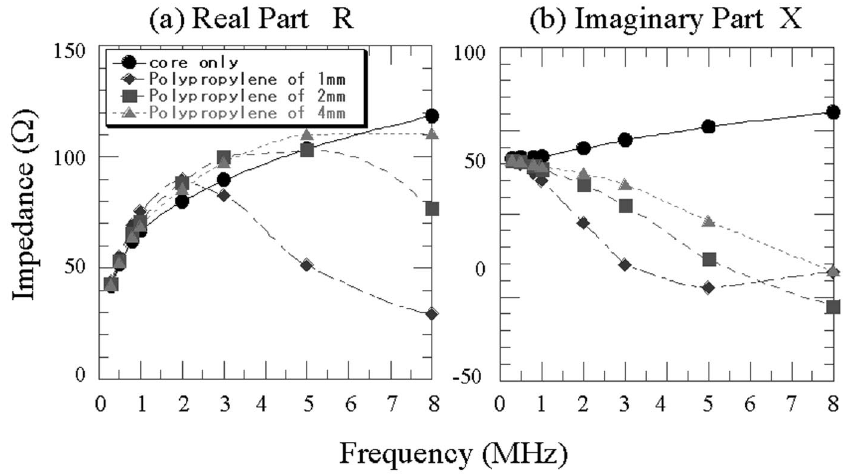
FIG. 5. Core impedances for the case after installing polypropylene sheets of 0.5 mm (triangles), 1 mm (squares), and 2 mm (diamonds) thickness. Polypropylene sheets were attached to both sides of the core and then sandwiched with metallic plates. Core impedances without metallic cooling plates are indicated by a